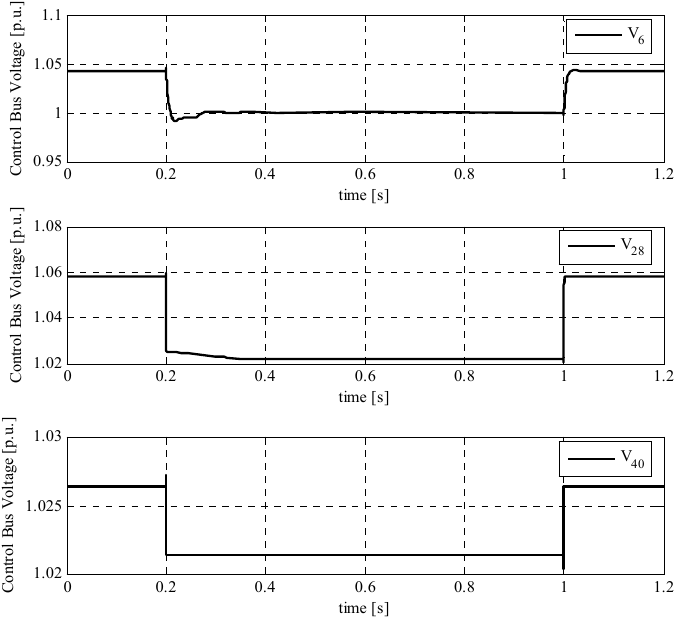
Figure 12. Time domain behavior of the voltages at the selected control buses.